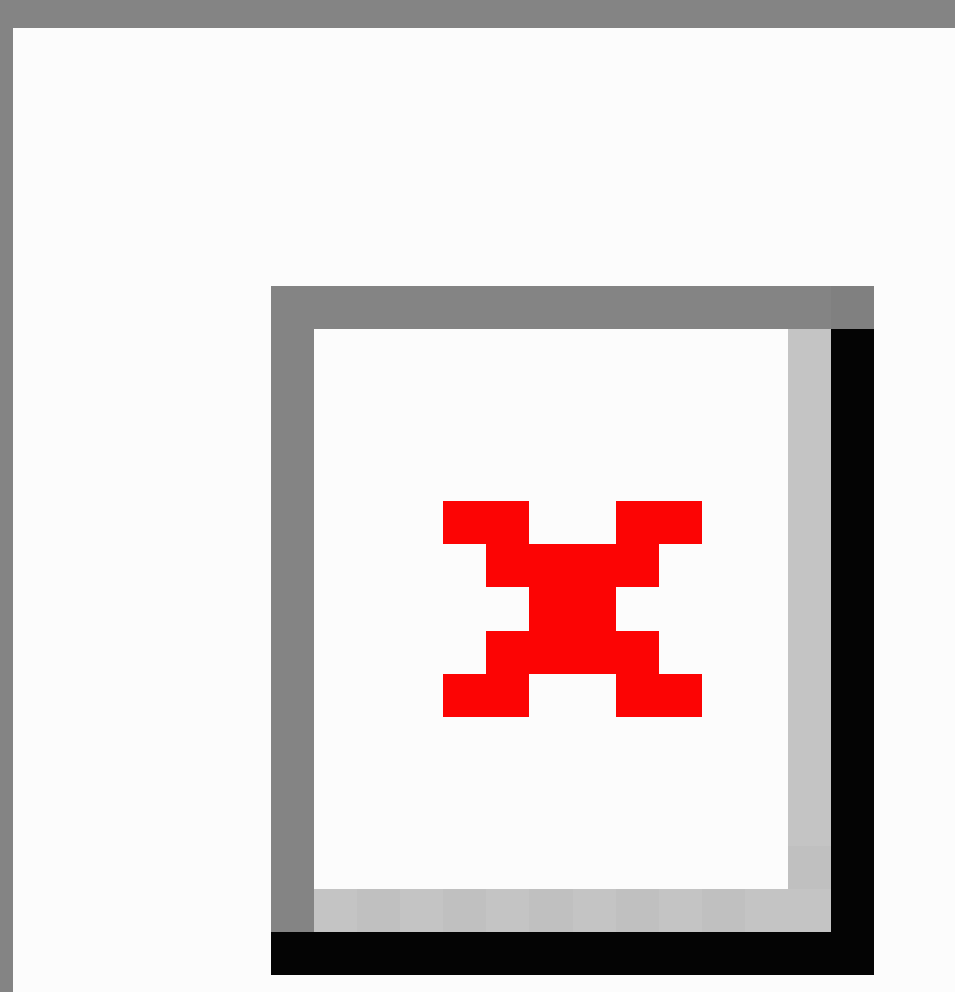
Figure 5. Antenna sites: Brooklyn Borough, New York. Black circles indicate gaps in